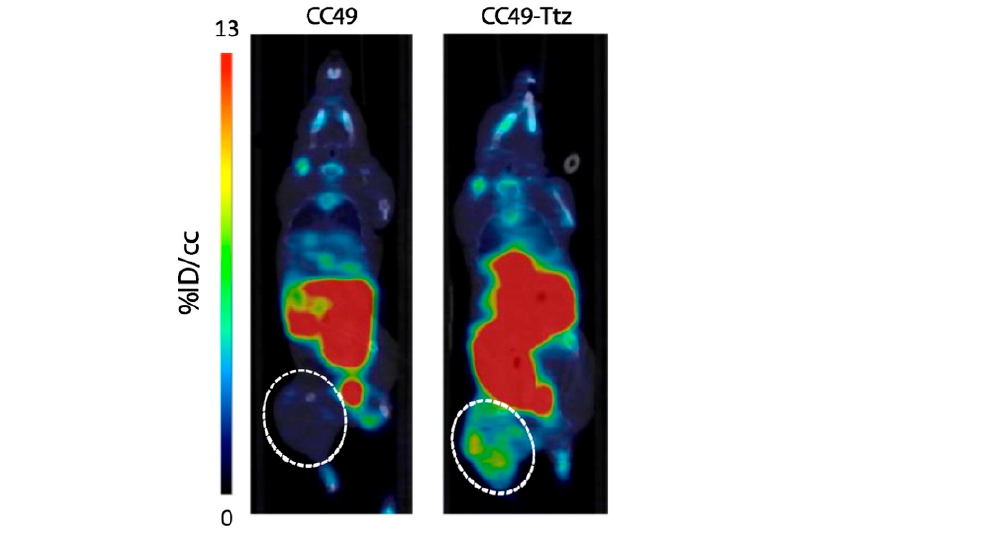
Figure 5. Representative microPET images of LS174T tumor-bearing mice injected with [ 18 F]F-MICA-205 24 h after the injection of CC49 (left) or CC49-Tz (right). Static images were acquired 1 h after administration of the [ 18 F]F-MICA-205. The white dashed line encircles the tumors [86].